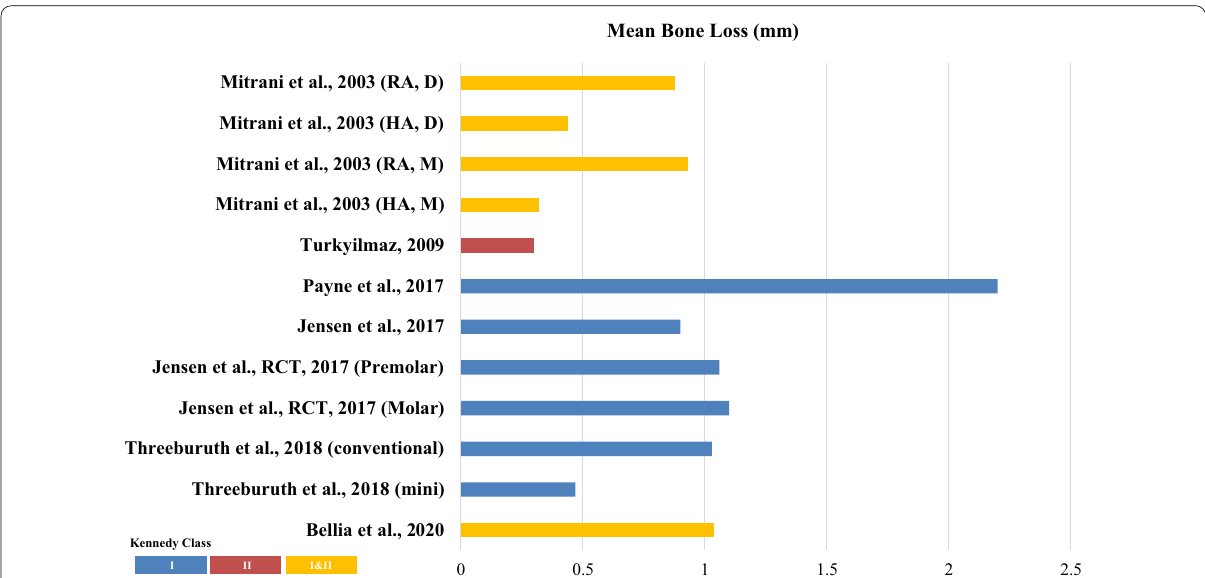
Fig. 3 Comparison of the mean bone loss between the included studies based on Kennedy classification of the study populations. RA resilient attachment, HA healing abutment, D distal surface, M mesial surface, Conventional conventional sized implant, Mini mini